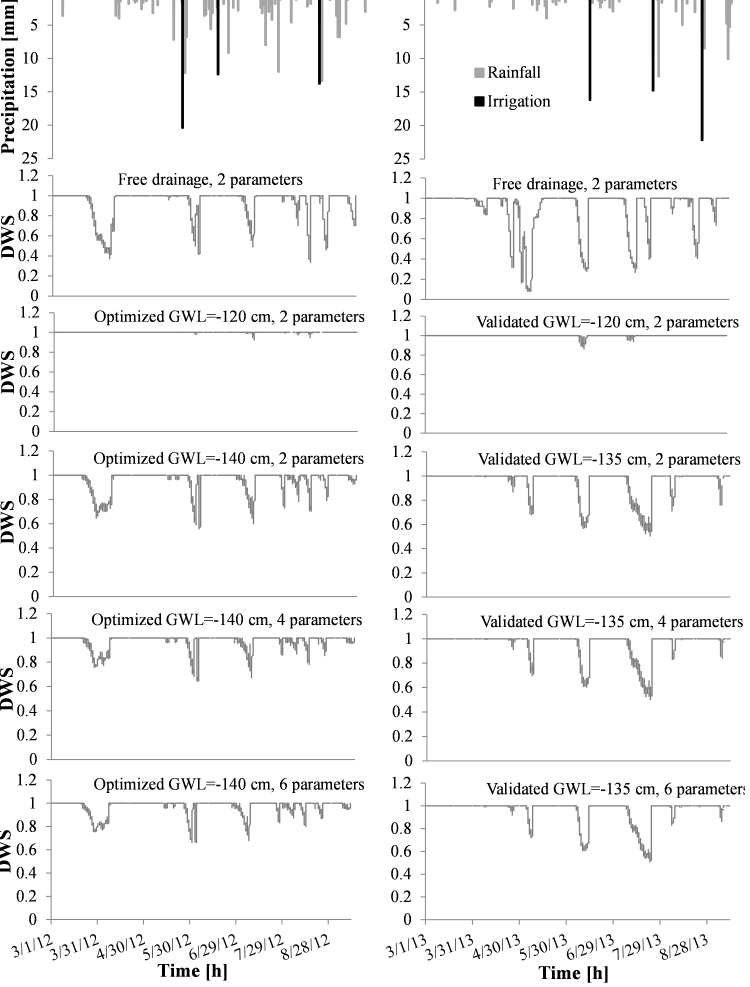
Figure 6. Degree of water stress at potential reference evapotranspiration in 2012 and 2013 for various scenarios and bottom boundary conditions. Table 5. Comparison of optimized irrigation schedule with farmer’s conventional irrigation